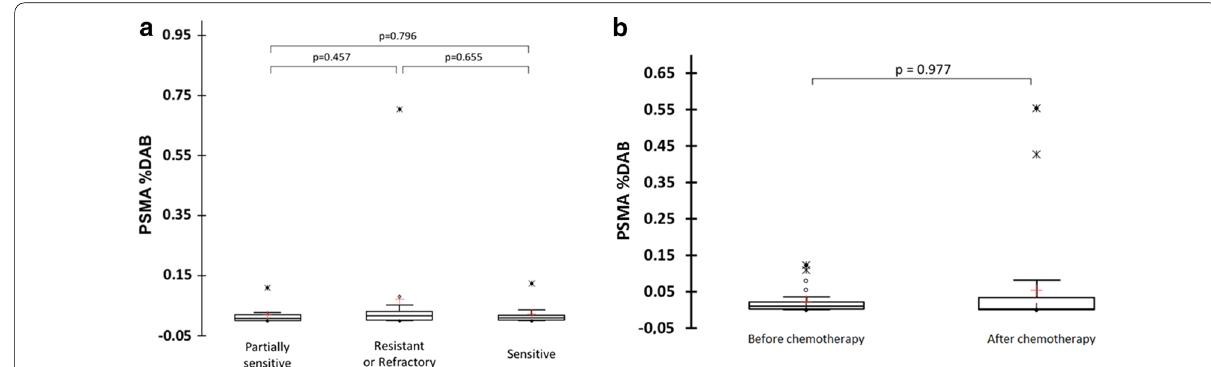
Fig. 2 Comparison of PSMA expression represented as a proportion of DAB ( a ) between sensitive, partially sensitive and resistant/refractory ovarian tumours and ( b ) between pre‑chemotherapy and post‑chemotherapy samples. Lines denote median values, 10th and 90th percentiles, red crosses denote mean